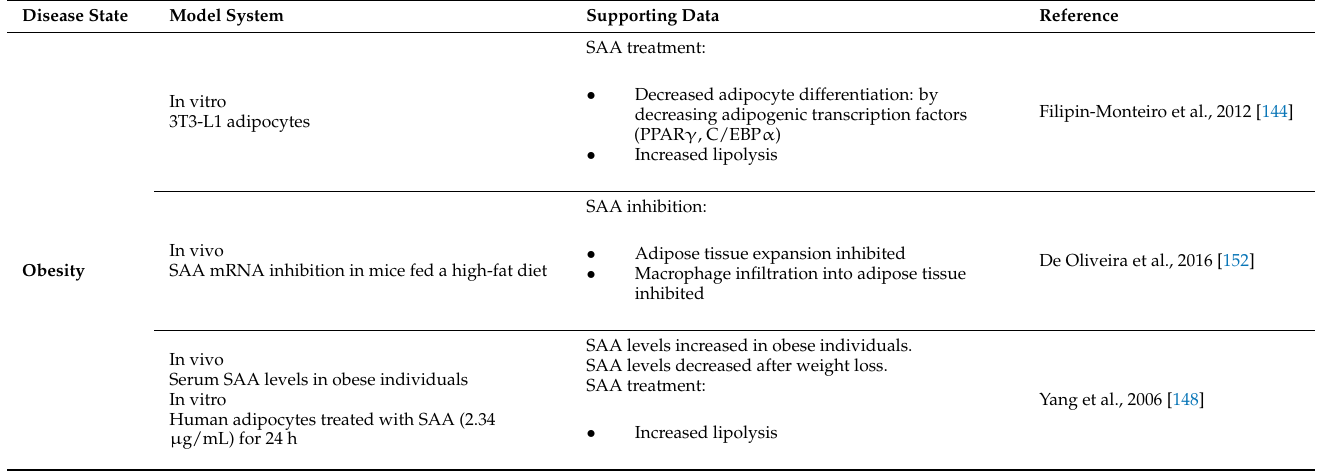
Table 2. Studies supporting the role of SAA in the development of obesity, insulin resistance, and type-2